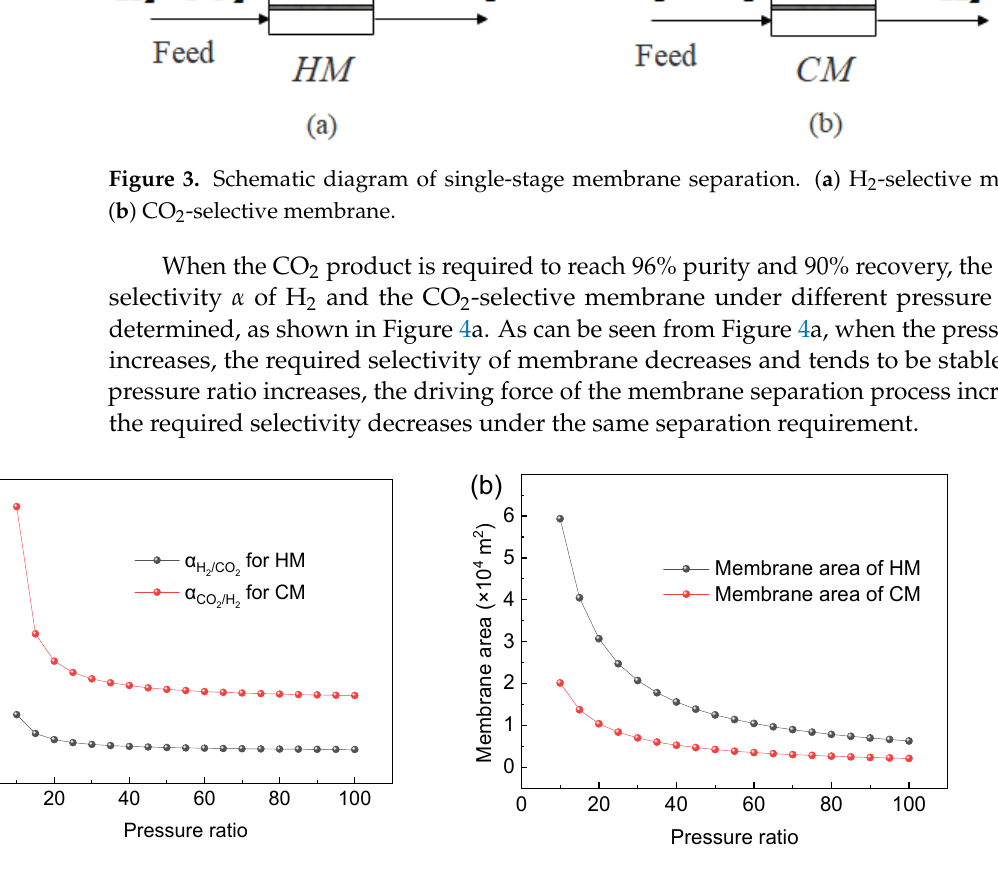
Figure 3. Schematic diagram of single ‐ stage membrane separation. ( a ) H 2 ‐ selective membrane; ( b ) CO 2 ‐ selective membrane.